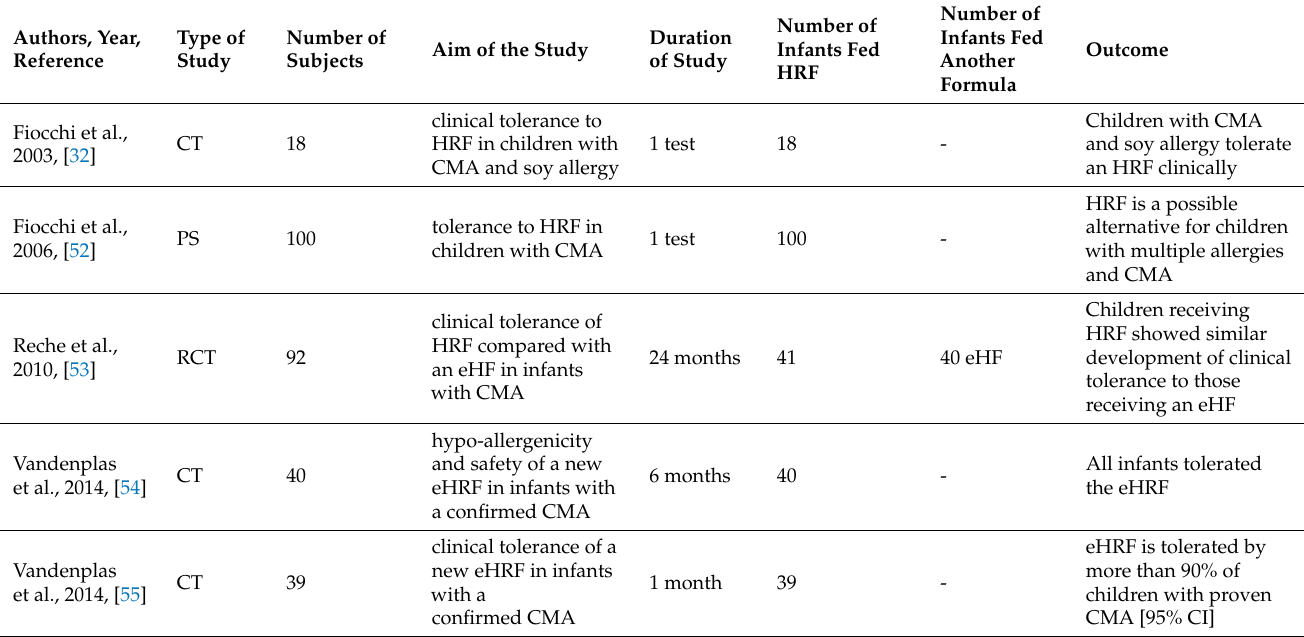
Table 1. Main studies evaluating efficacy and safety of